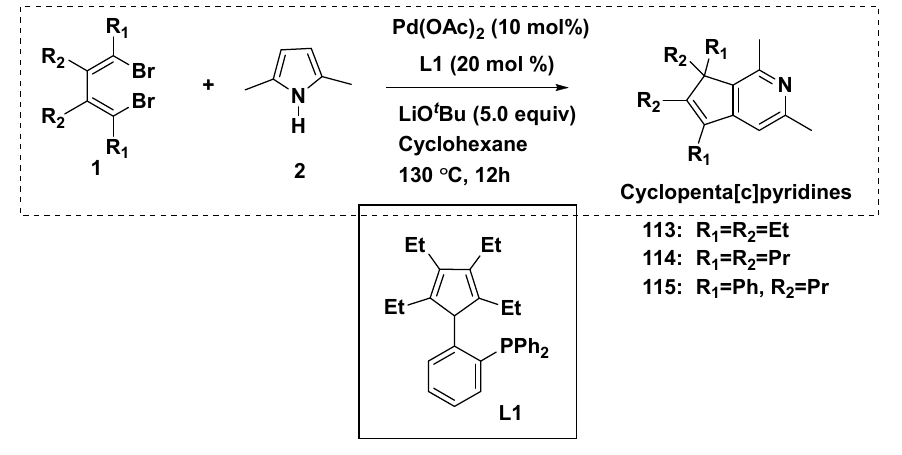
Scheme 12. Reactions afforded cyclopenta[c]pyridine derivatives.